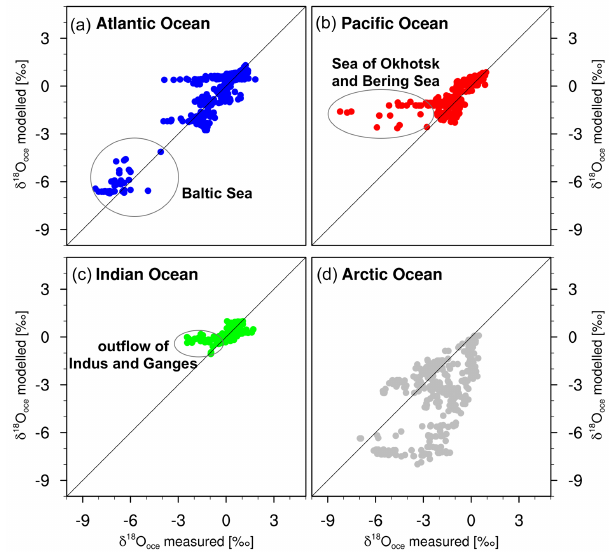
Figure 3. Scatter plots of observed present-day δ 18 O oce values from the GISS database vs. modelled δ 18 O oce values of the PI simulation for the following basins: (a) Atlantic Ocean, (b) Pacific Ocean, (c) Indian Ocean, and (d) Arctic Ocean. The black lines rep- resent the 1:1 line, indicating a perfect model